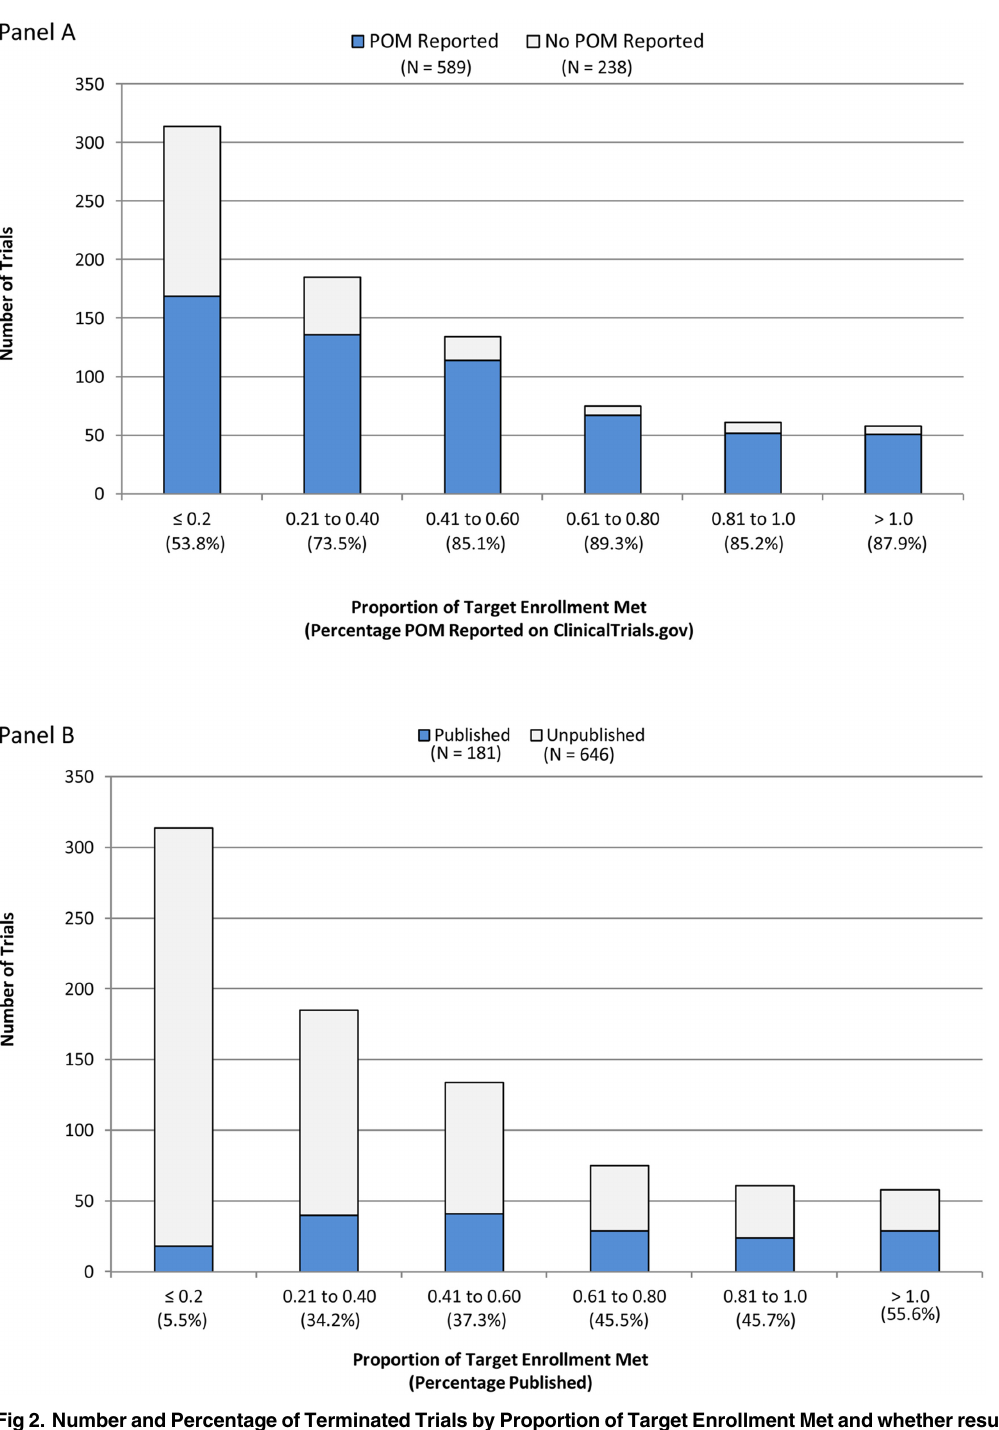
Fig 2. Number and Percentage of Terminated Trials by Proportion of Target Enrollment Met and whether results for a Primary Outcome Measure (POM) were (a) reported on ClinicalTrials.gov or (b) published in a biomedical journal (as of December 2013).